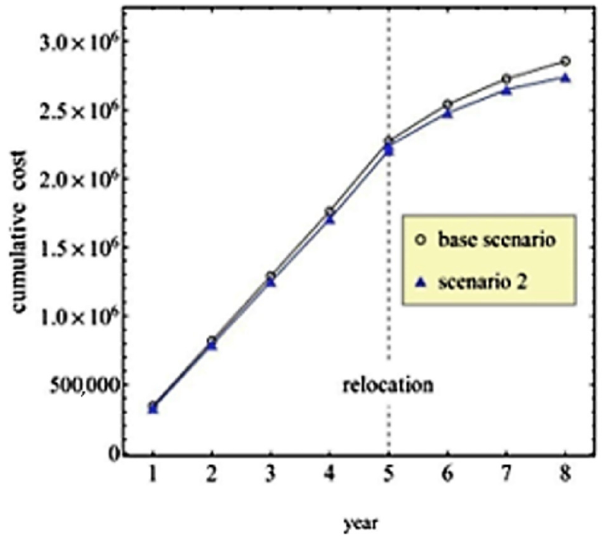
Figure 8. Comparison of cumulative costs.